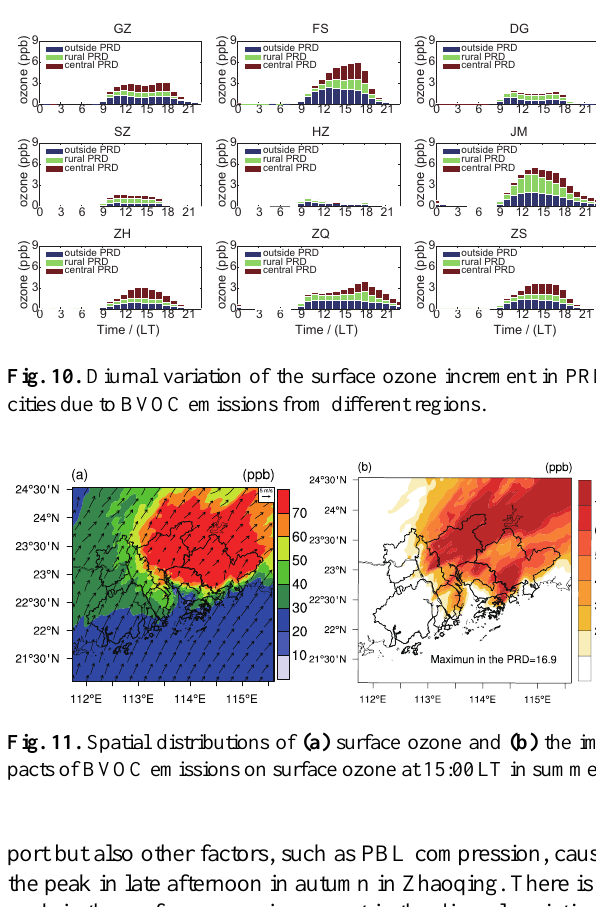
port but also other factors, such as PBL compression, cause the peak in late afternoon in autumn in Zhaoqing. There is a peak in the surface ozone increment in the diurnal variations in Guangzhou and in Huizhou in summer, which is related to the influence of transport and the accumulation caused by the decreasing PBL